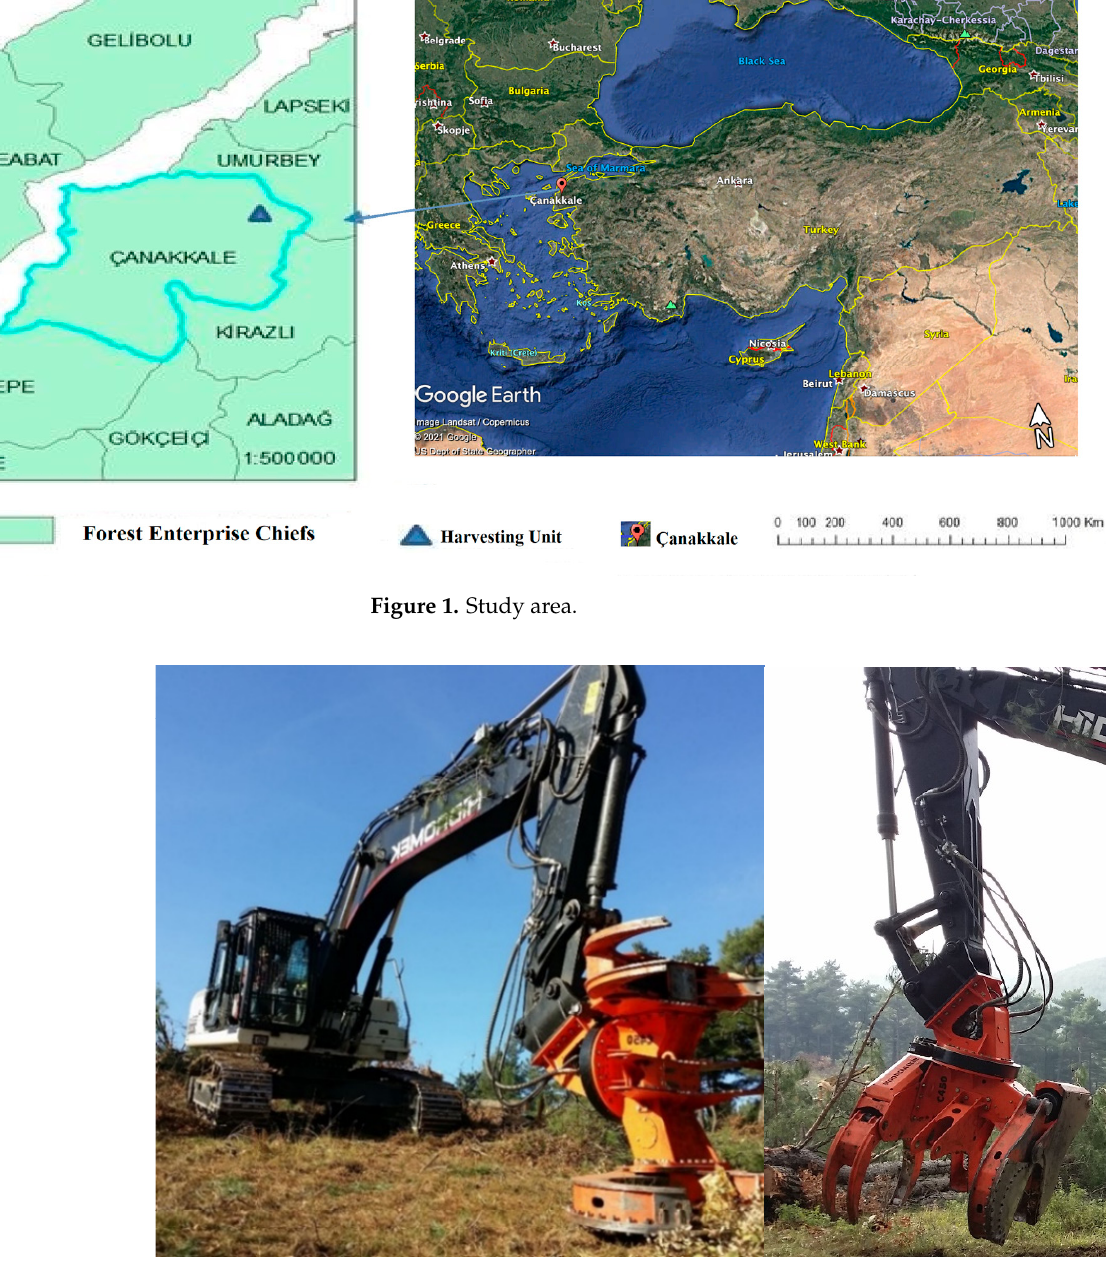
Figure 2. Westtech Woodcraker C450 model feller-buncher with cutting head.